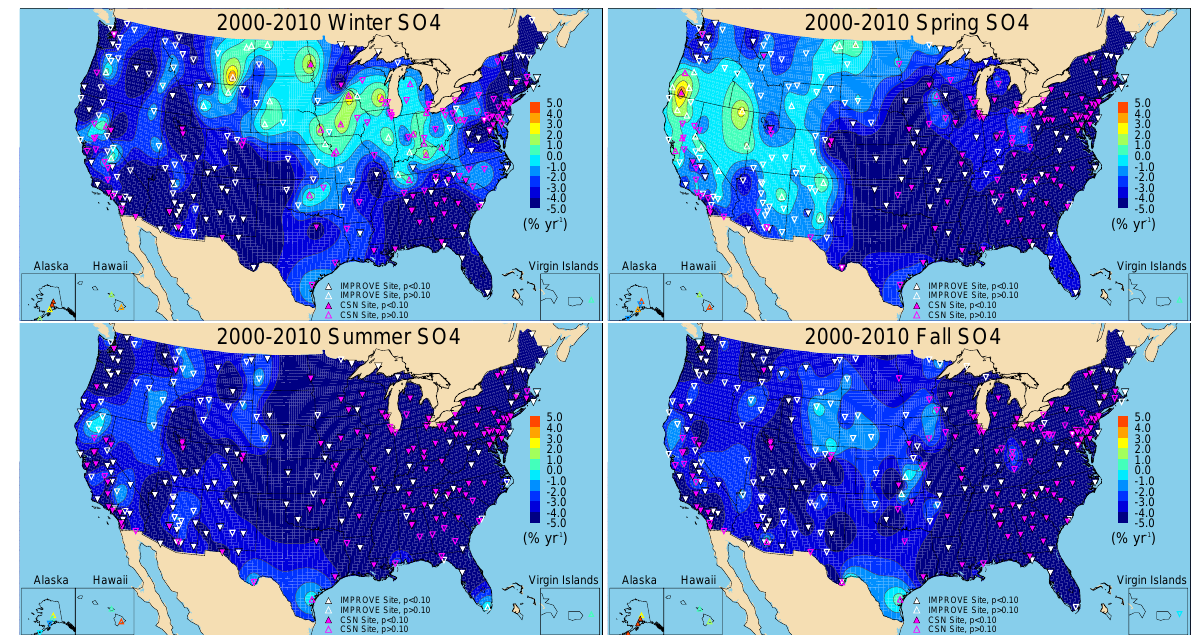
Fig. 4. IMPROVE and CSN 2000–2010 trends (% yr − 1 ) in seasonal mean particulate sulfate ion concentrations for (a) winter (DJF), (b) spring (MAM), (c) summer (JJA) and (d) fall (SON). White and magenta triangles correspond to IMPROVE and CSN sites, respectively; upward pointing triangles correspond to increased concentrations and vice versa. Trends with significance levels ( p ) less than 0.10 are considered